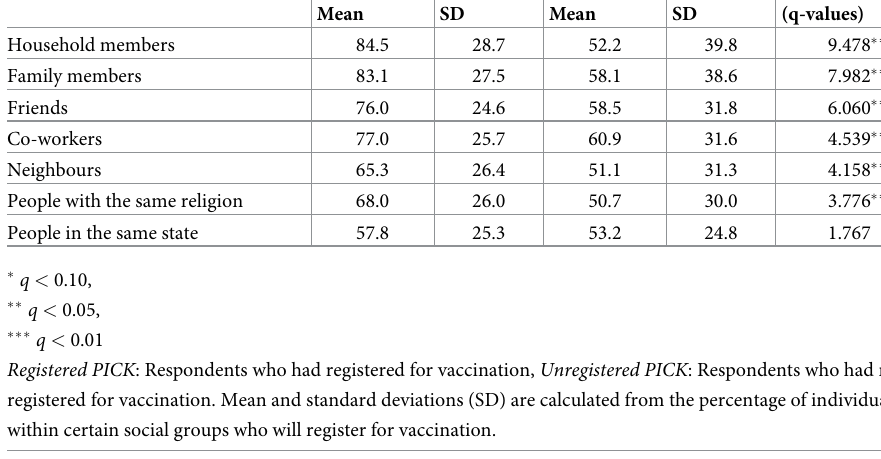
Table 3. Summary statistics and statistical differences in expectations that others will register for vaccination. Social